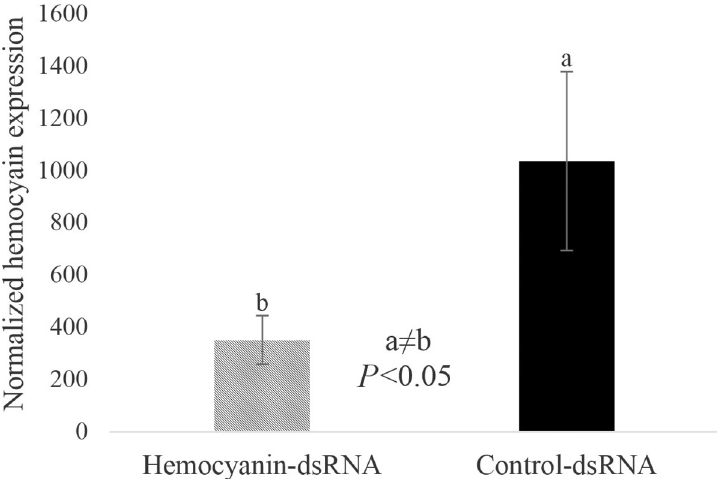
Fig 7. Hemocyanin-1 expression 10-days post injection in blue color morph D . citri adults. qPCR quantification of hemocyanin-1 (relative to α -tublin) in D . citri adults revealed significant reduction of hemocyanin-1 expression in dsRNA microinjected insects compared to control dsRNA injected